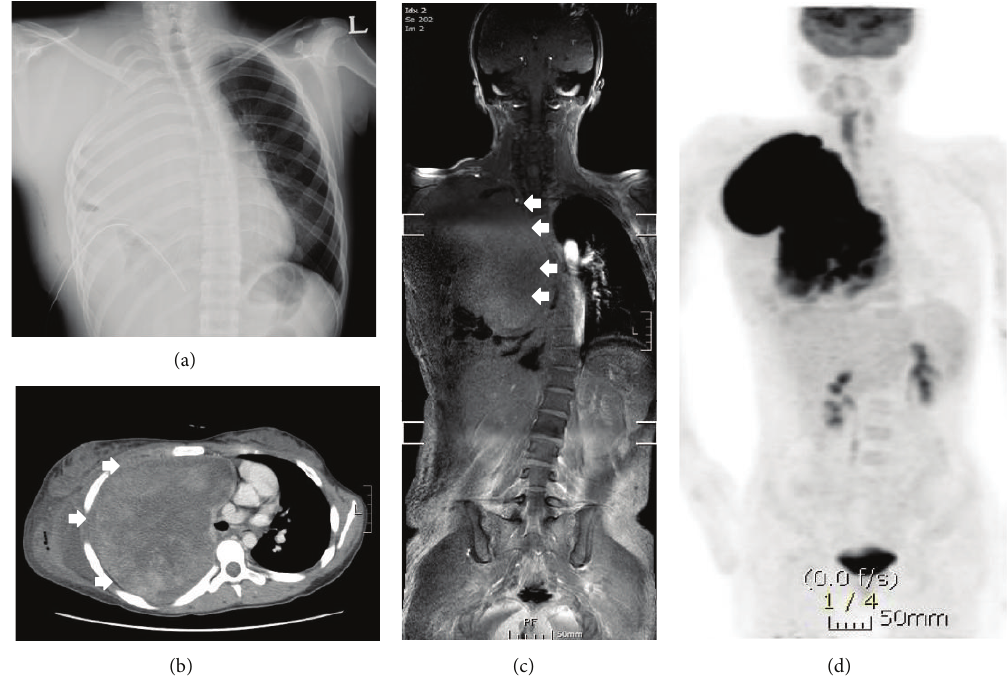
Figure 1: The patient’s chest radiography shows a large thoracic mass with total collapse of right lung (a). Her chest CT scan (b) and spine MR imaging (c) also show a large intrathoracic hyperdense mass (white arrows) in the right chest, resulting in prominent scoliosis and cardiac deviation. Her 18 F-FDG PET/CT scan showed highly increased FDG uptake (SUV max = 6.9 ) in this mass, suggesting highly malignant tumor